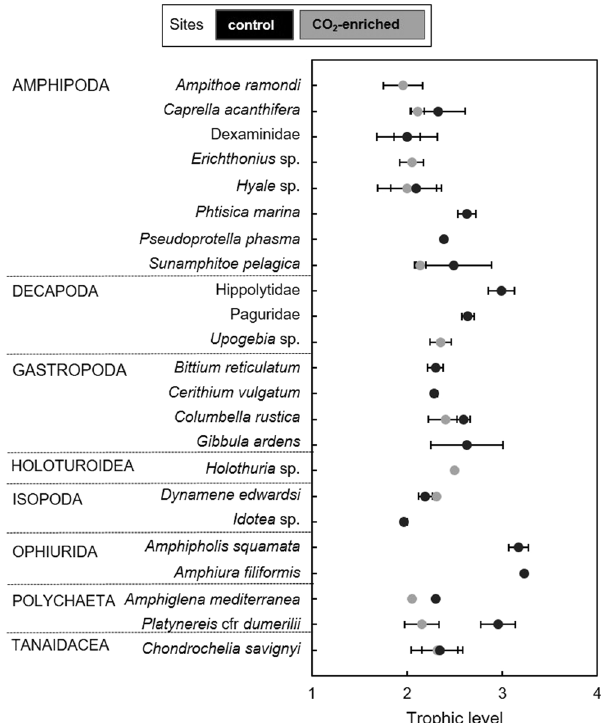
Figure 4. Trophic position ( ± standard deviation) of motile invertebrates associated with macrophytes at the control (black) and CO 2 -enriched (grey)